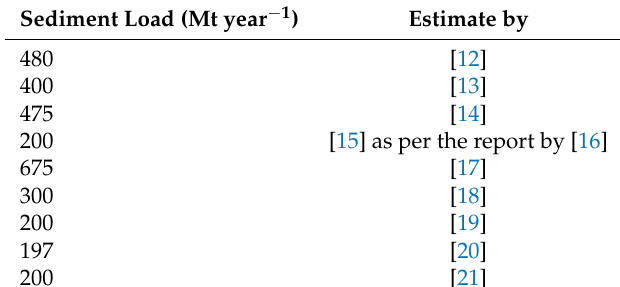
Table 1. Published estimates of sediment load (SL) of the Upper Indus River.